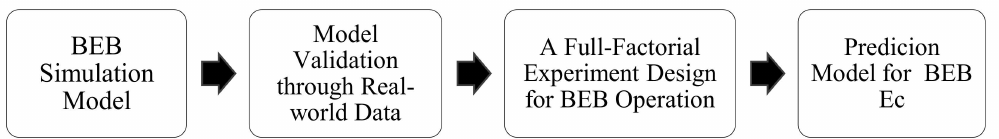
Figure 2. A simple flow chart of the four-step methodology.